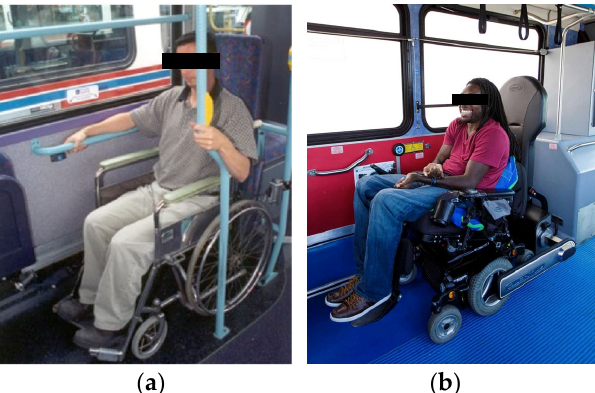
Figure 3. Rear ‐ facing wheelchair passenger station ( a ) and Q’Straint Quantum automated docking system ( b ).